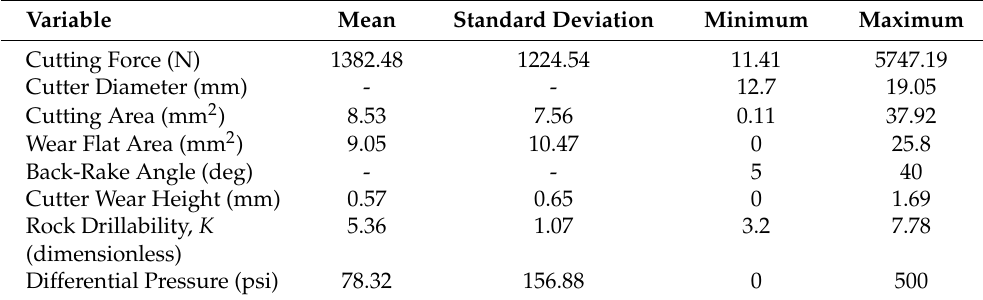
Table 4. Statistical summary of experimental data employed in regression of F c (Number of observa- tions